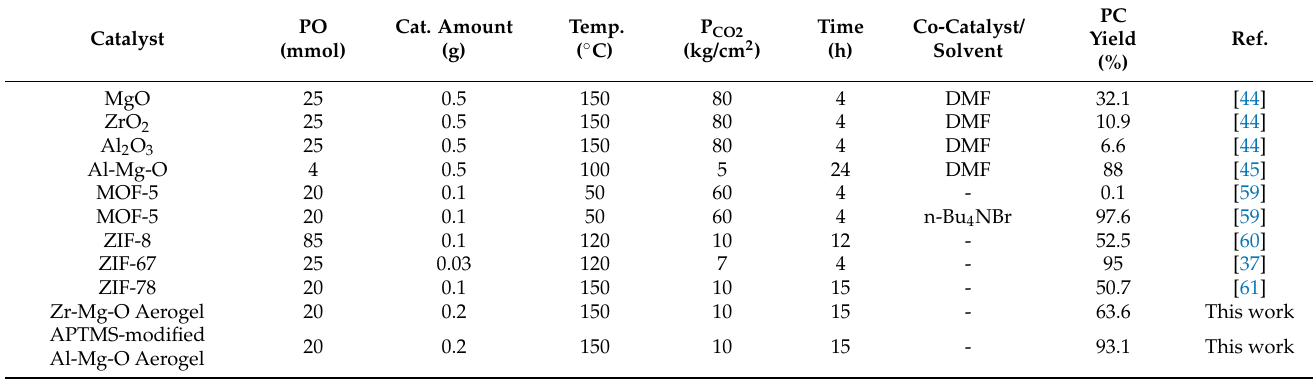
Table 6. The literature comparison of the PC yield using different heterogeneous catalysts and the APTMS-modified Zr–Mg mixed oxide